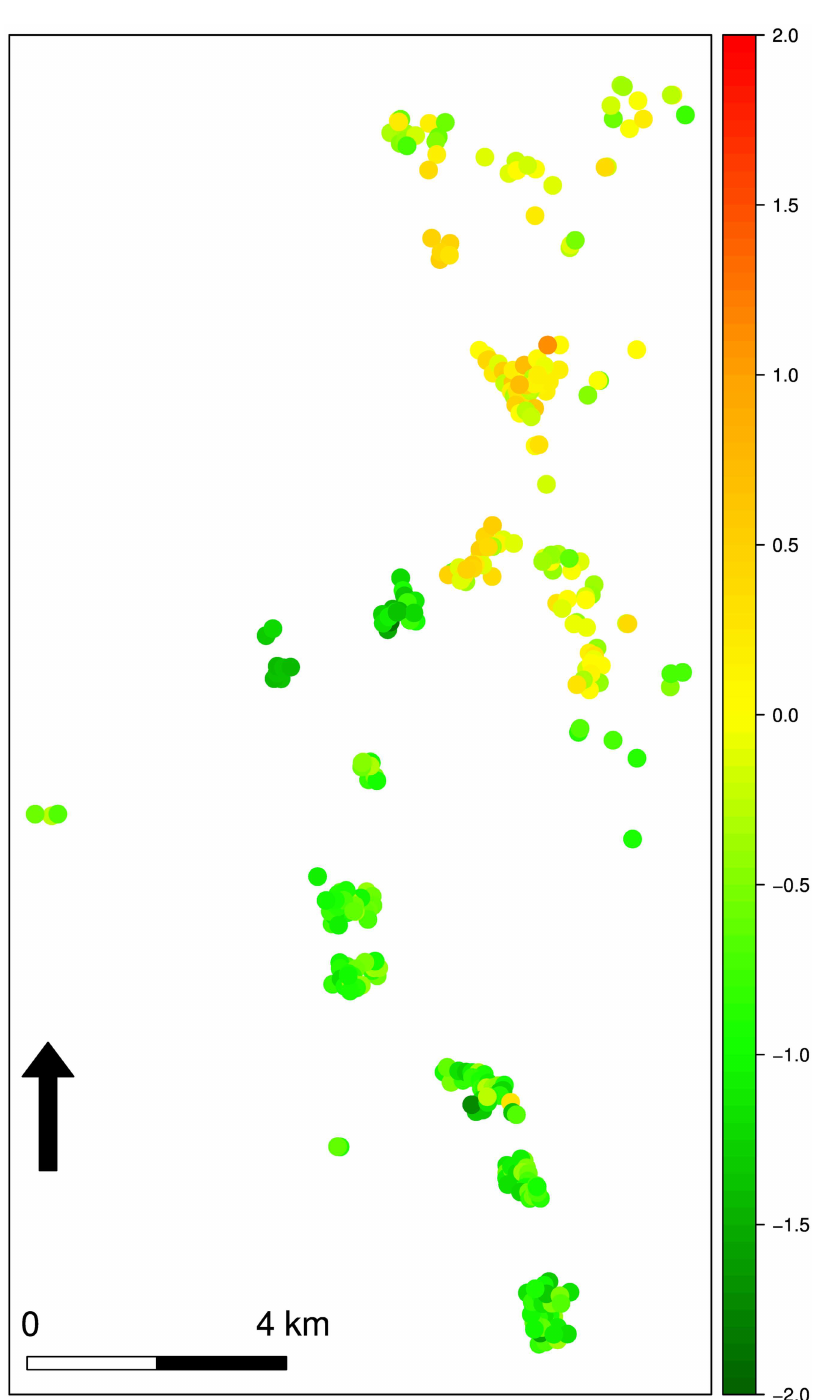
Fig 4. Unexplained spatial variation map. Contributions of the linear regressionand of the unexplained spatialvariationto the predicted log-oddsof malariaprevalencein children6–59months at each of the observedlocationsin focal area